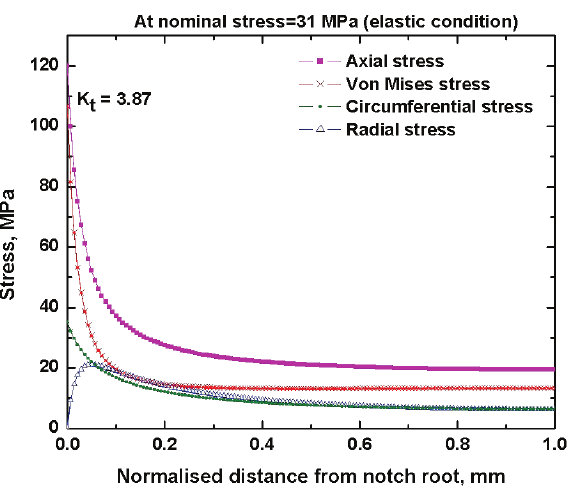
Figure 8. Effect of notch on reduction in area as a function of nitrogen content at room temperature and 823 K.